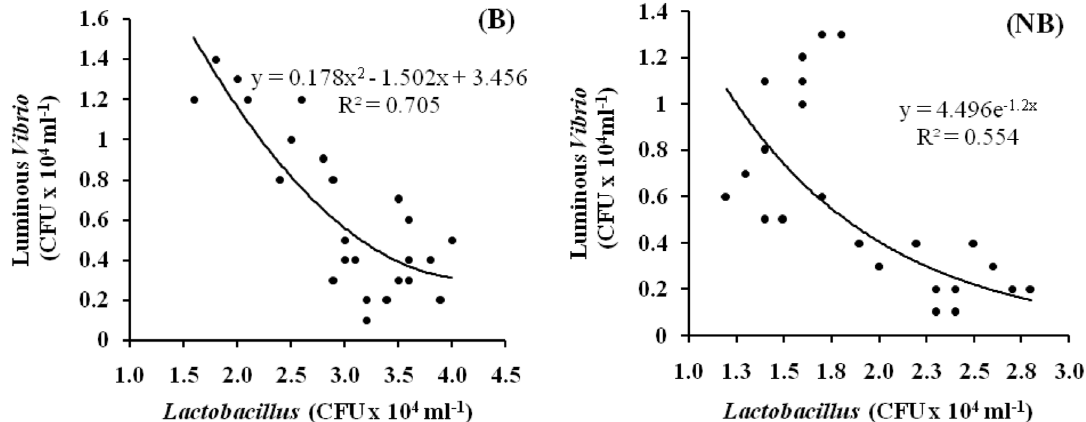
Fig. 1. Fitted relationship between Lactobacillus sp. and luminous Vibrio sp. in water in without (B) and with neem (NB) based bio fl oc culture system of L. vannamei